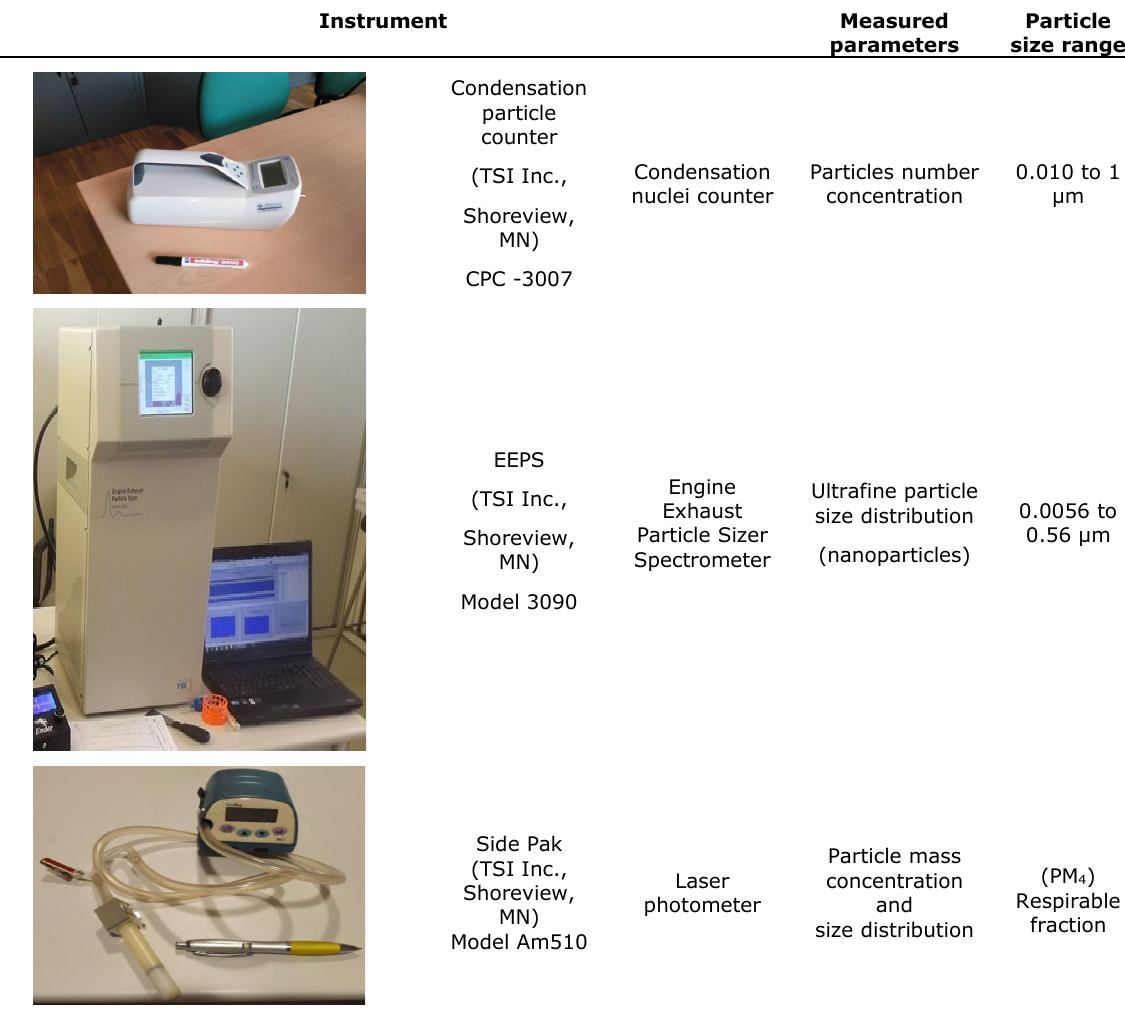
Table 1 Direct reading instruments used for monitoring the particulate